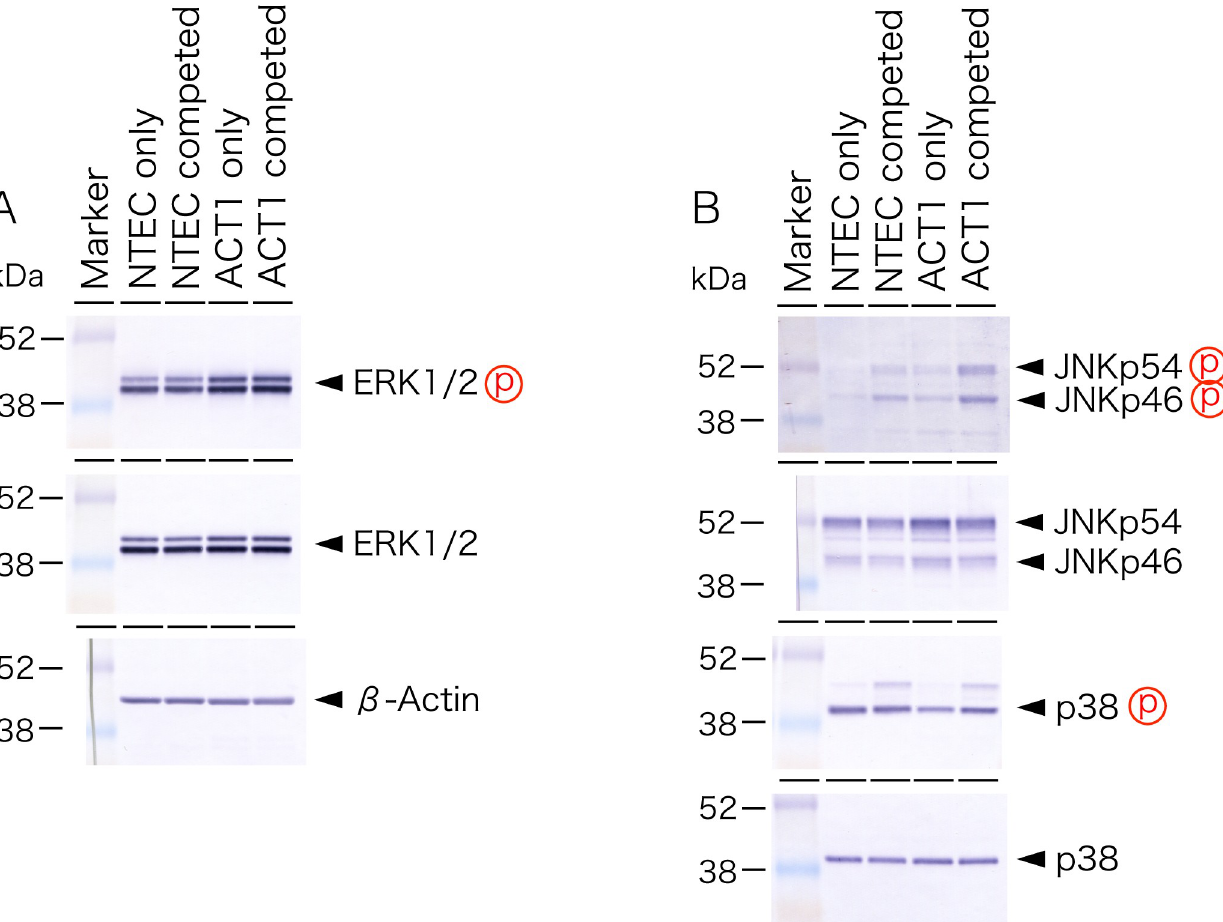
Fig 9. Western blot analysis of MAP-kinase pathway. Total protein was extracted from both NTECs and ACT1 cells cultured either alone (NTEC or ACT1 only, respectively) or from cell co-cultures (NTEC or ACT1 competed, respectively) and subjected to western blot analysis with indicated antibodies.